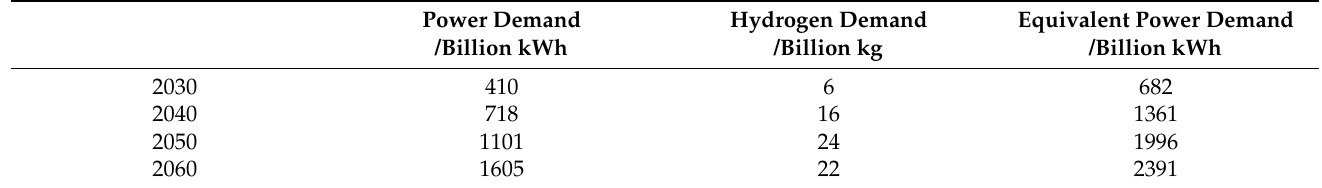
Table 3. Power and hydrogen demand in the transport sector in China.